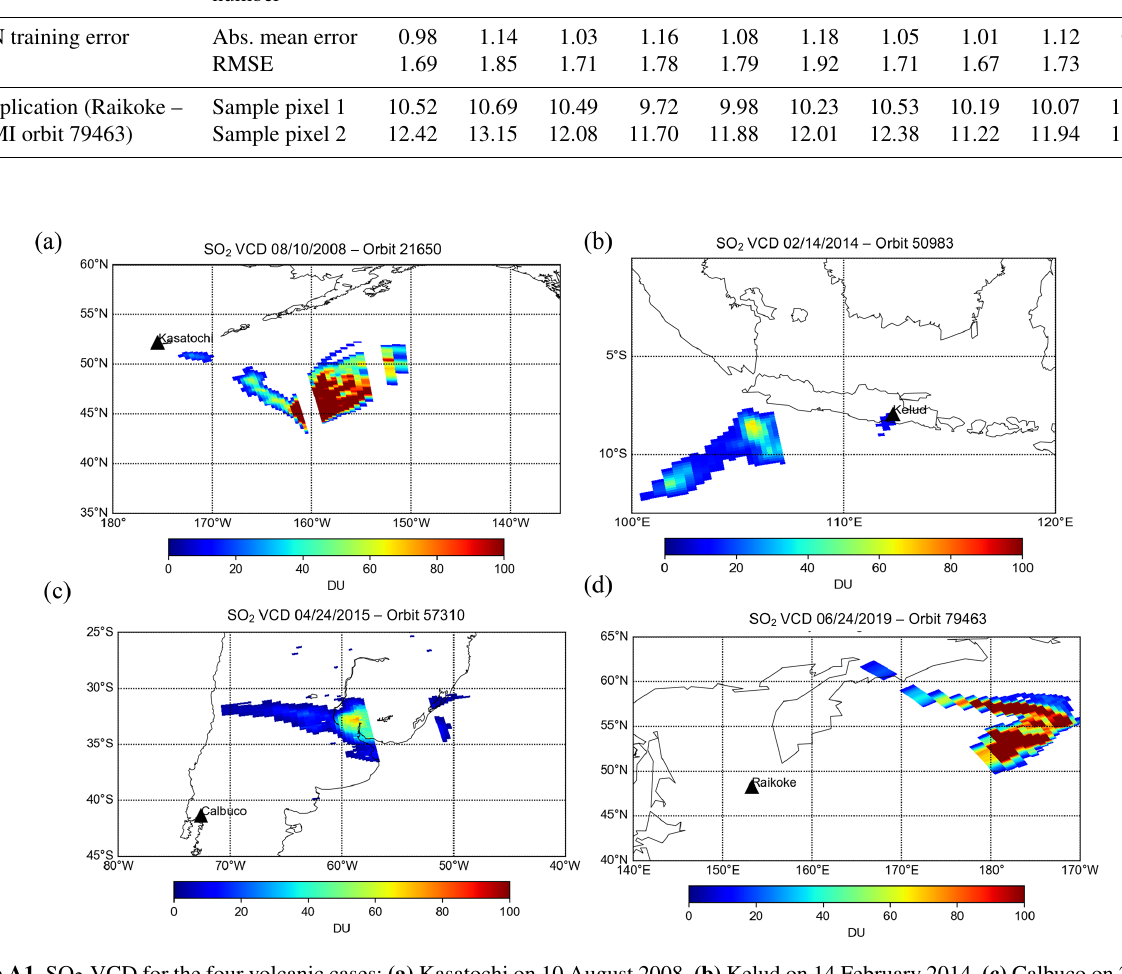
Figure A1. SO 2 VCD for the four volcanic cases: (a) Kasatochi on 10 August 2008, (b) Kelud on 14 February 2014, (c) Calbuco on 24 April 2015, and (d) Raikoke on 24 June 2019. In these maps, only pixels with SO 2 > 10DU are